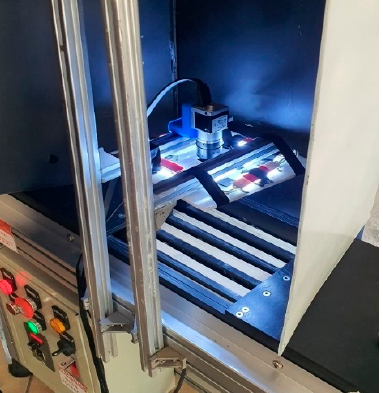
Figure 4. Camera and light